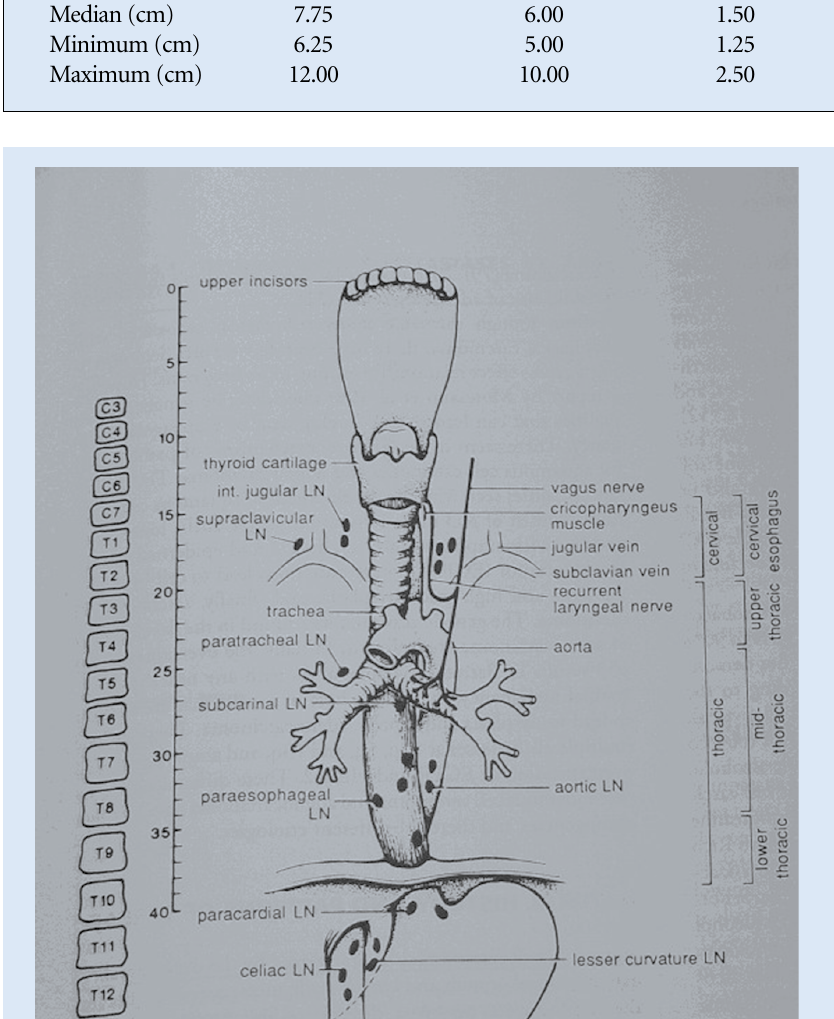
Fig. 2. Basic anatomy of the oesophagus showing four vertebrae = 10